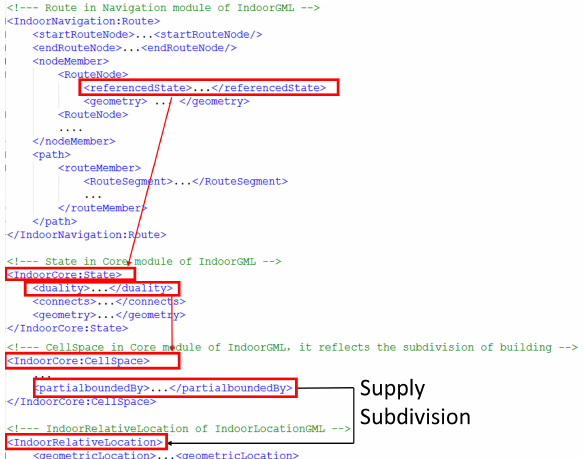
Figure 7. IndoorGML supplies subdivision result for IndoorRelativeLocation instances